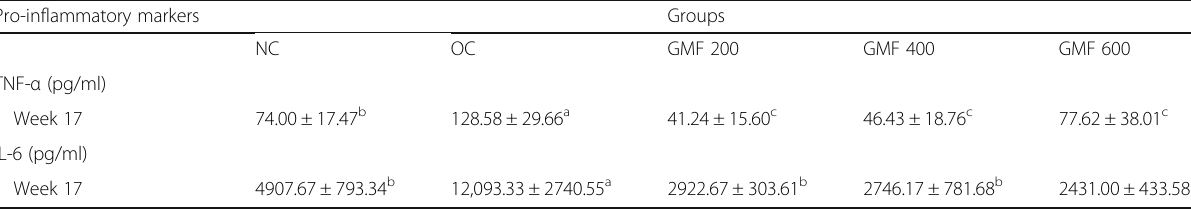
Table 4 The effect of GMF supplementation on inflammatory markers Pro-inflammatory markers Groups